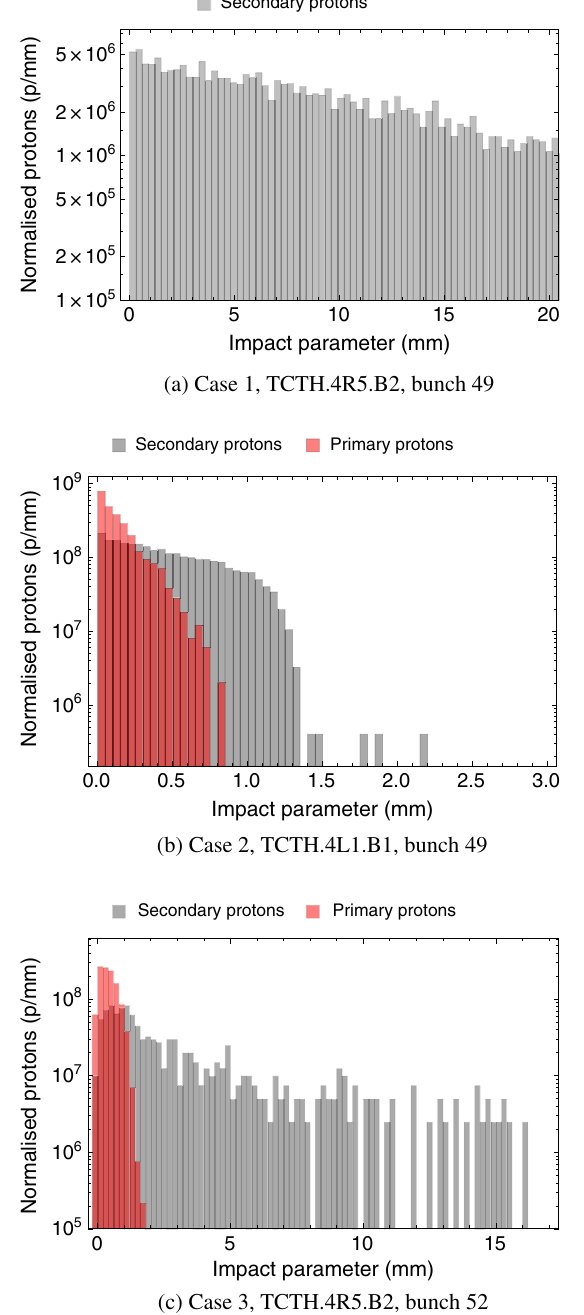
FIG. 21. Transverse impact distribution at the face of the TCT for the most impacting bunch in different simulated scenarios. In each case, the histogram bars are normalized to the bin size and to the total number of protons lost. Losses are calculated consid- ering a bunch population of 1 . 3 × 10 11 for nominal LHC optics (Cases 1 and 2), and 2 . 2 × 10 11 for HL-LHC optics (Case 3).